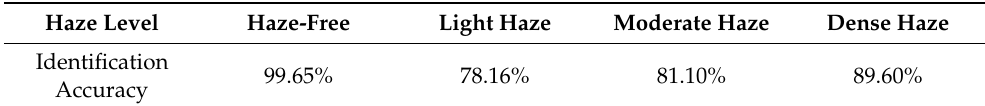
Table 2. Environment identification performance by haze level.